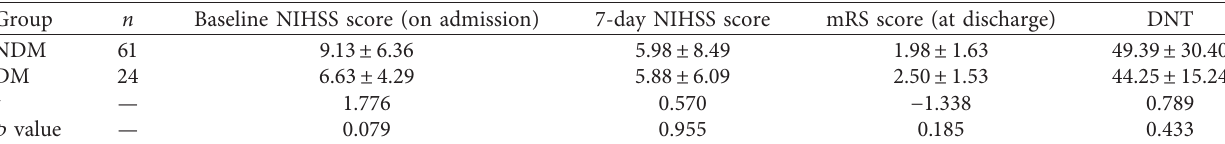
Table 3: Comparison of outcomes of rtPA intravenous thrombolysis of both groups.